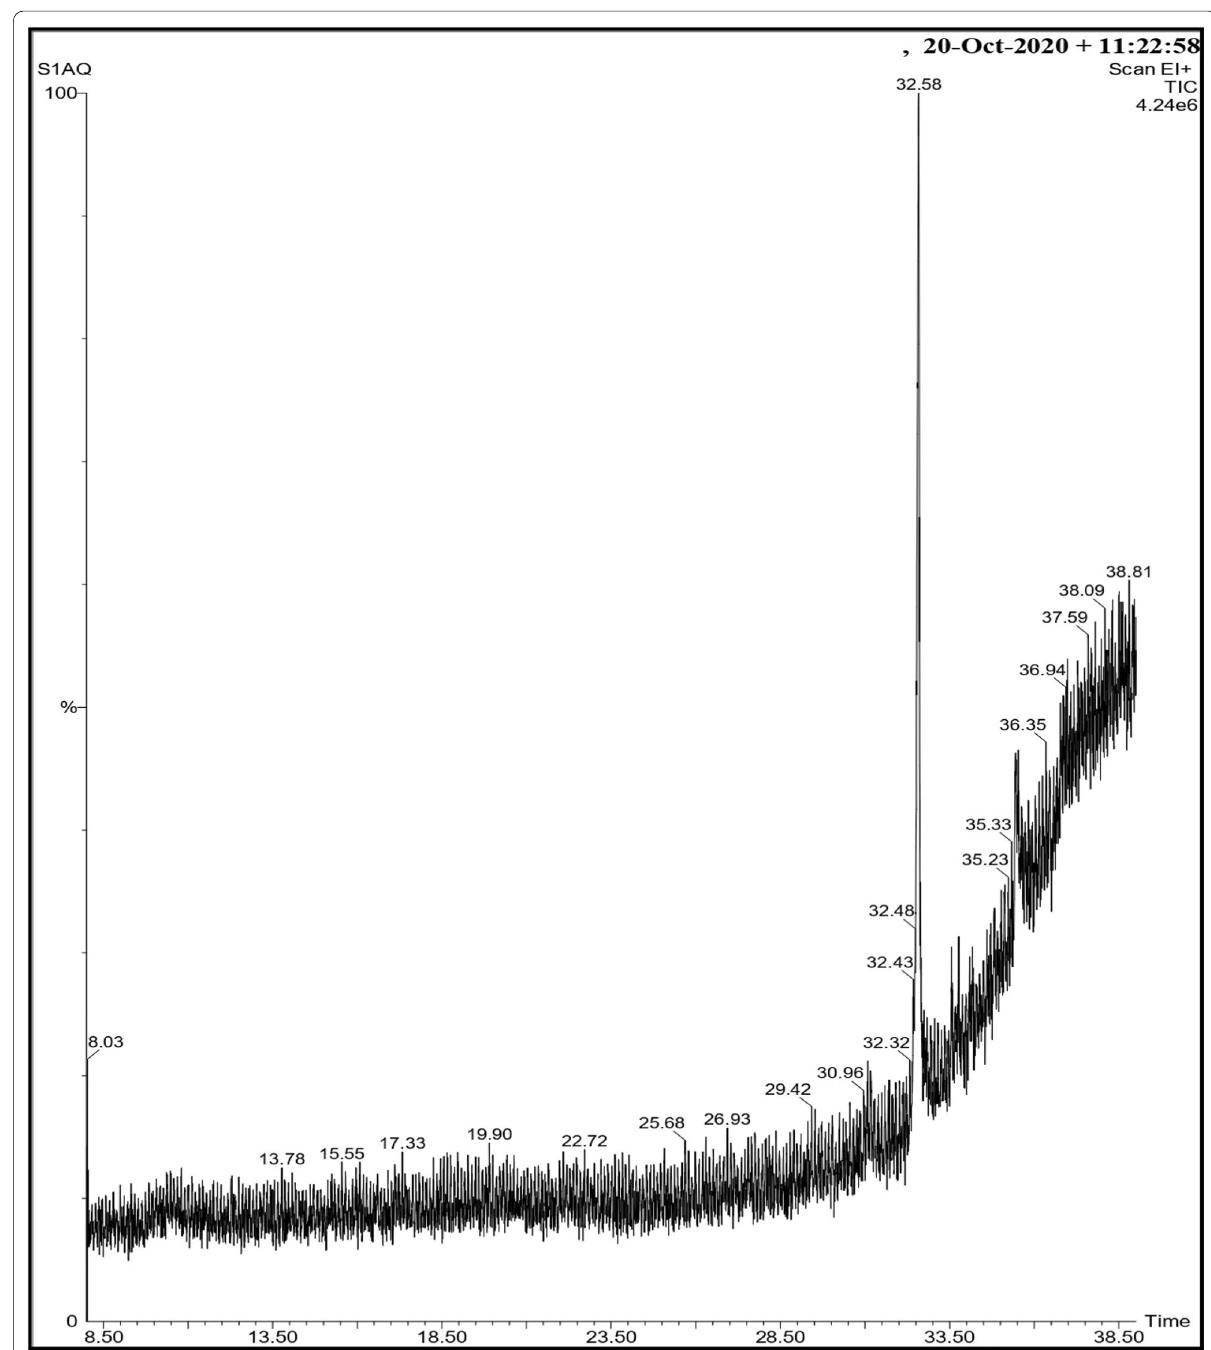
Fig. 8 GCMS chromatogram of E. indicum (aqueous